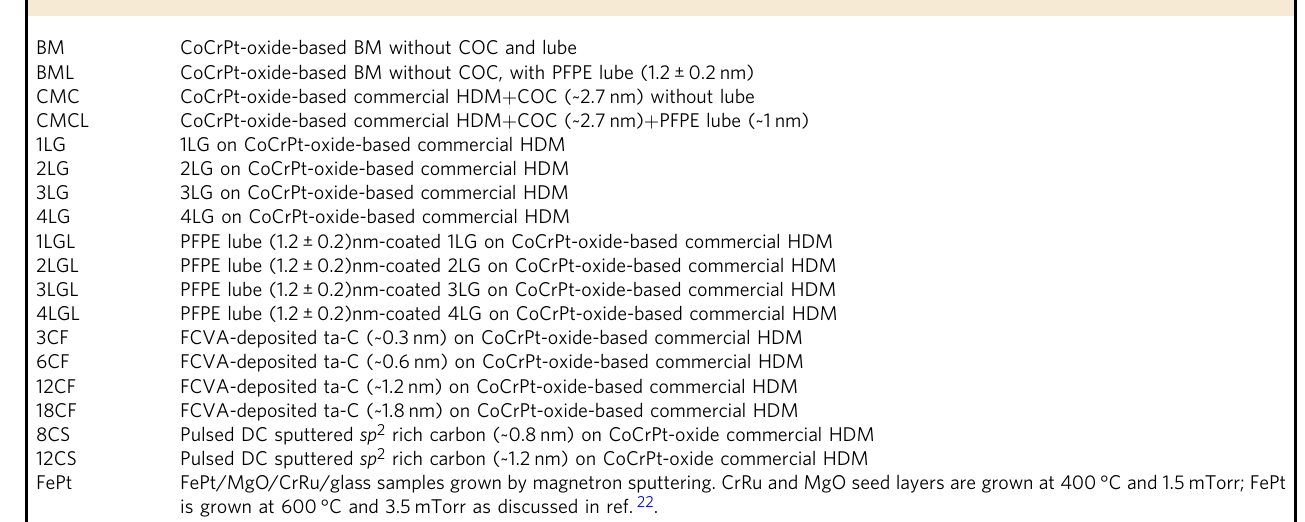
Table 1 List of samples. BM CoCrPt-oxide-based BM without COC and lube BML